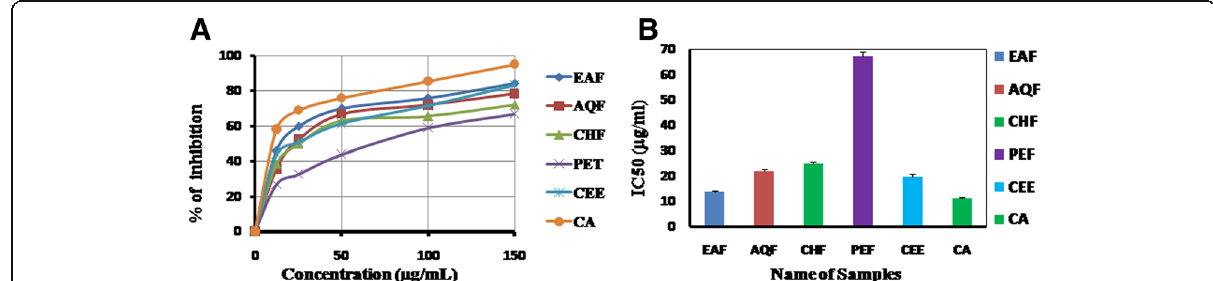
Fig. 3 Determination of ( a ) lipid peroxidation inhibition of CEE and its various fractions (EAF, AQF, CHF and PEF) and ( b ) IC 50 of CEE and its various fractions (EAF, AQF, CHF and PEF) determined from lipid peroxidation inhibition assay. Data expressed as mean ± SD ( n = 3, p < .01) for all tested dosages